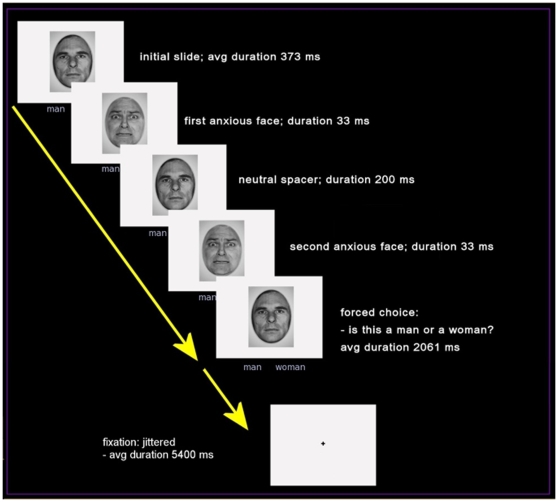
Design of backward masking trials used in the fMRI study.From trial onset the subject is presented with a male or female face. Inserted into this presentation are two subthreshold presentations of different corresponding male or female face. Each trial began with the presentation a neutral face. After an average of 373 msec, a 33 msec anxious face appeared followed by the reappearance of the neutral face for 200 msec. A second 33 mec presentation of the anxious face occurred followed by the final presentation of the neutral face. Participants were asked to identify if the neutral face was a man or a woman. Each trial was followed by a fixation screen for an average of 5400 msec.